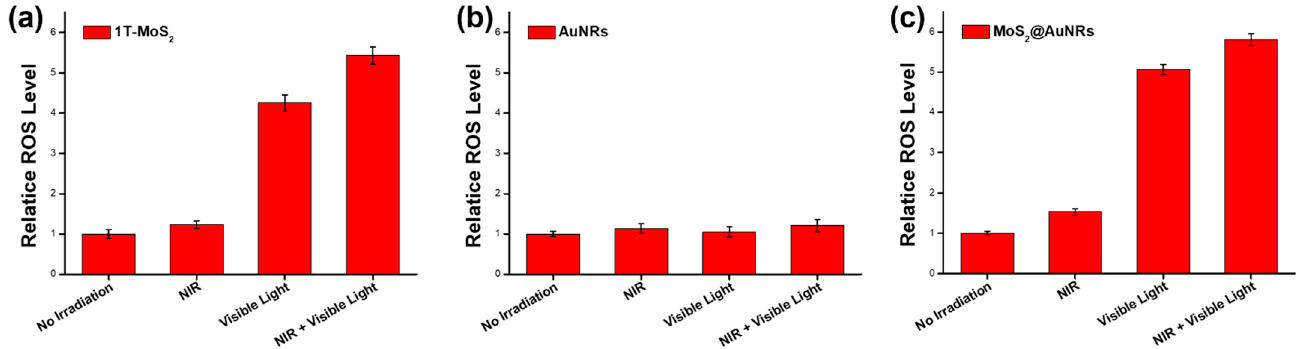
Figure 6. Relative reactive oxygen species (ROS) levels of ( a ) metallic molybdenum disulfide (1T-MoS 2 ) nanosheets (NSs), ( b ) gold nanorods (AuNRs), and ( c ) MoS 2 @AuNRs with no light irradiation and with near infrared (NIR) laser, visible light, and both NIR laser and visible light irradiation. All data are presented as the mean ± SD, n = 3 per group.